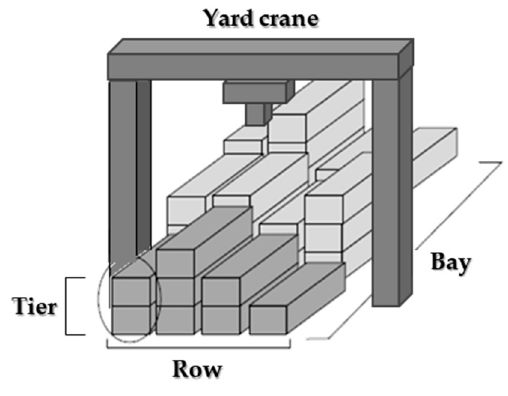
Figure 4. The configuration of the yard block.